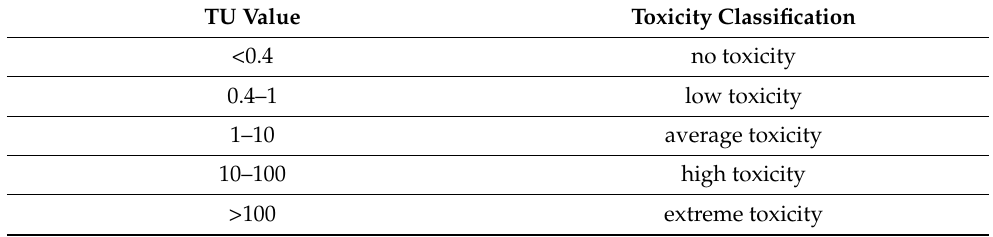
Table A4. The classification of wastewater according to the TU value [42].